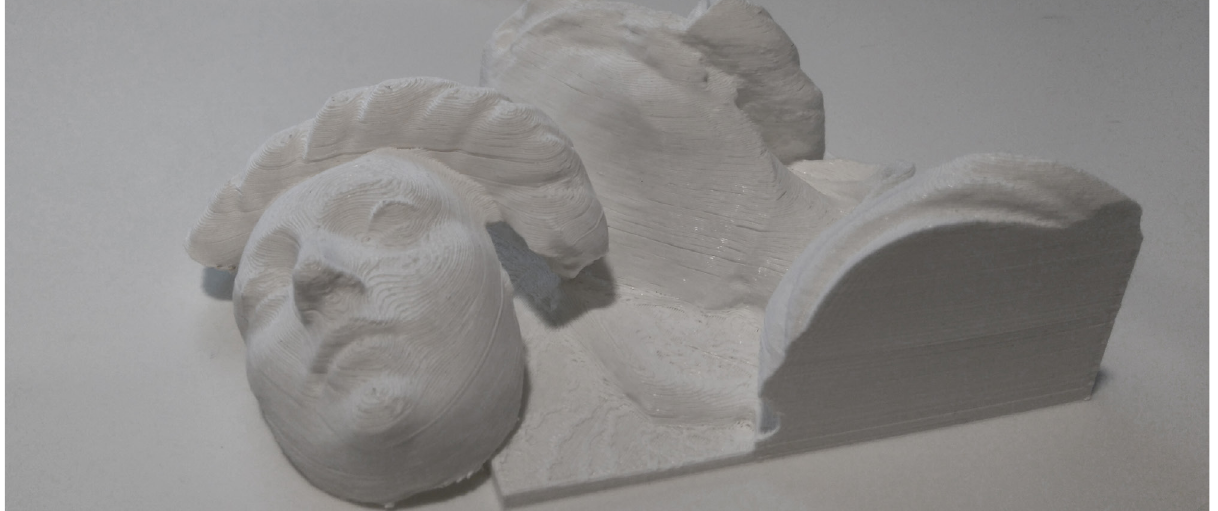
Figure 10. 3D printing of the surviving surface and of the reconstructed missing part: the models fit perfectly